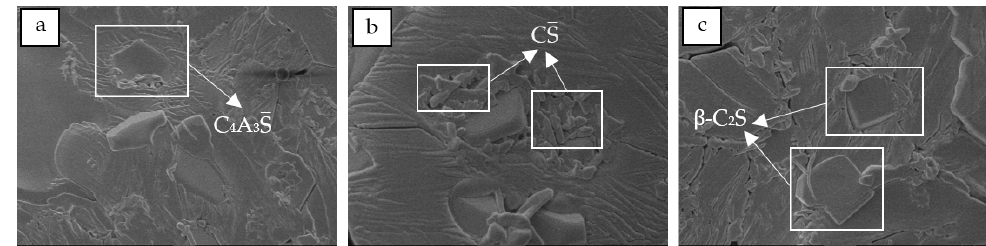
Figure 8. Micromorphology of the sample II-1 cement clinker: ( a ) C 4 A 3 S — ; ( b ) CS — ; ( c ) β -C 2 S.